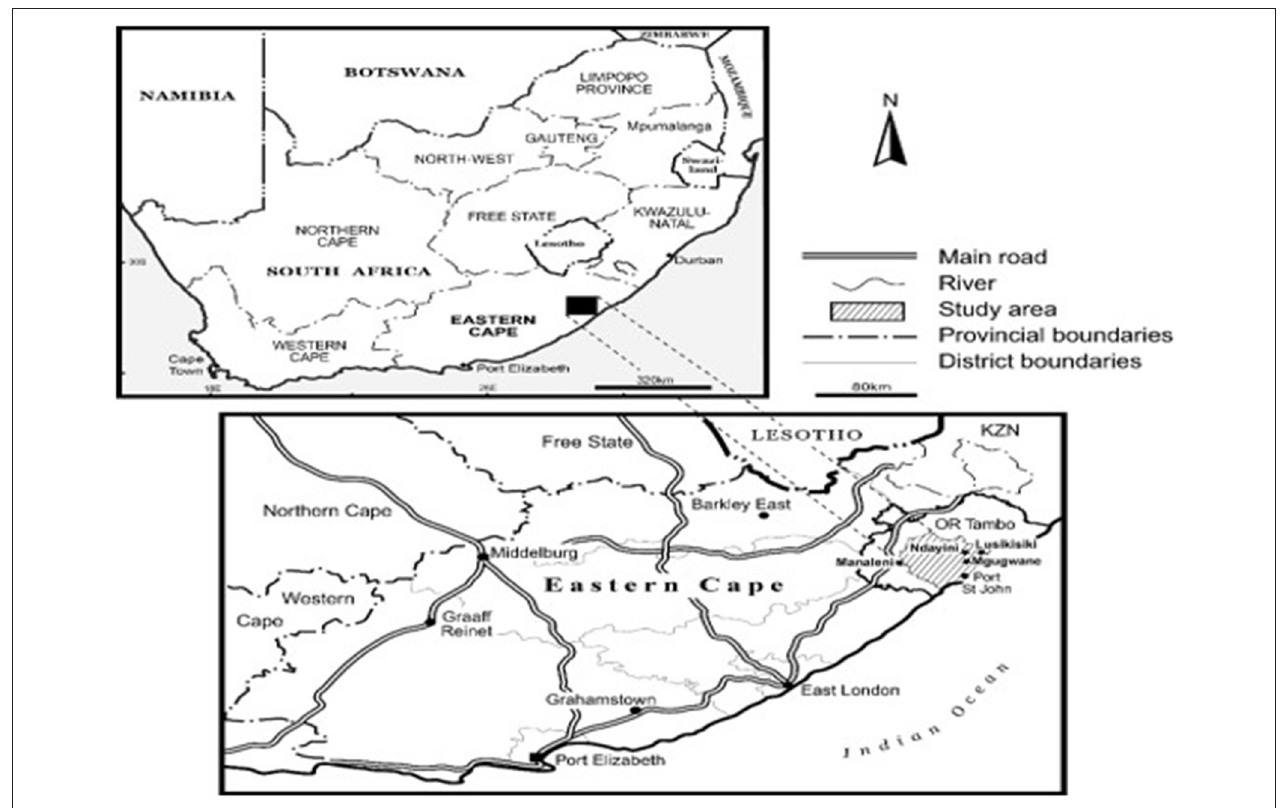
FIGURE 1 | Location of study sites in Eastern Cape Province. Source: Cartographic Unit, University of Witwatersrand